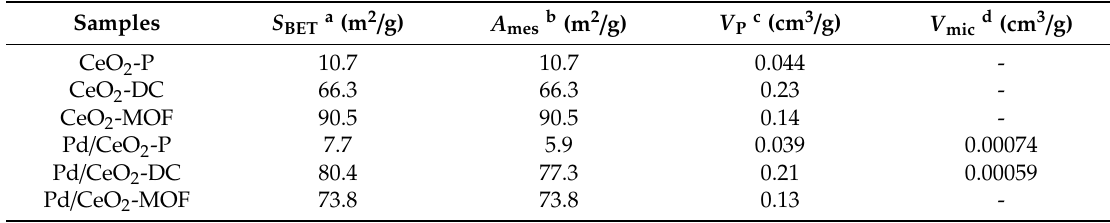
Figure 5. Textural properties of the samples: ( a ) N 2 adsorption / desorption isotherms; ( b ) pore size distributions. Table 1. Characteristic data of the samples.